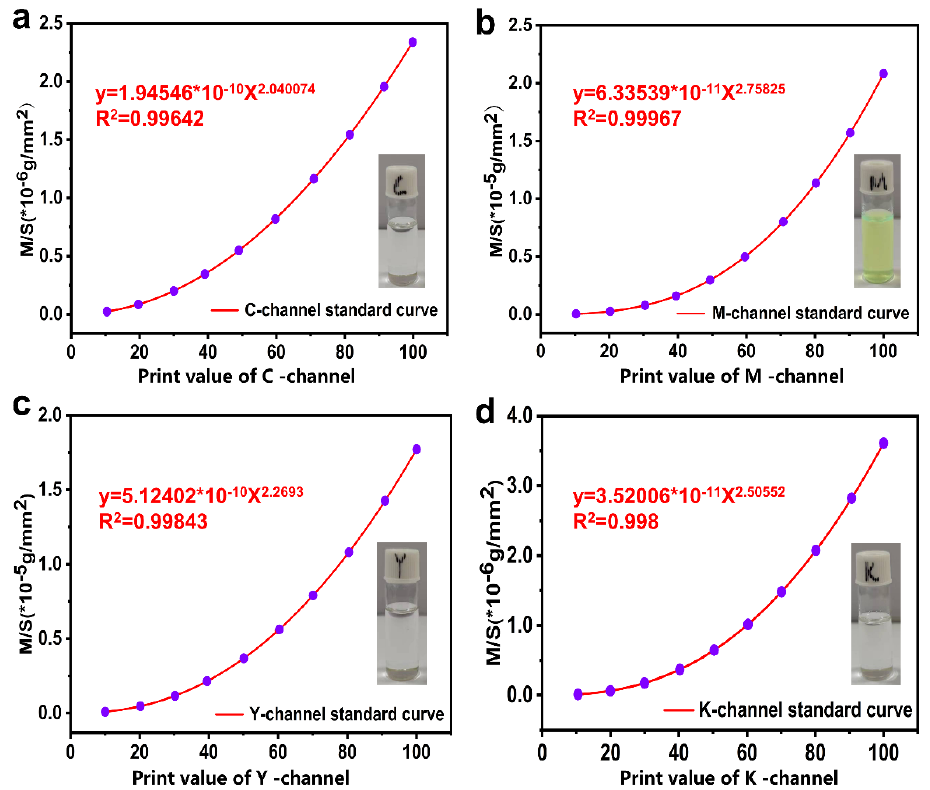
Figure 4. ( a ) C-channel standard curve: y = 1.9456 × 10 −1 0 X 2.040074 , R 2 = 0.99642. The ink used is 5 wt% S811. ( b ) M-channel standard curve: y = 6.33539 × 10 −1 1 X 2.75825 , R 2 = 0.99967. The ink used is 0.25 wt% 5 wt% S811. ( b ) M-channel standard curve: y = 6.33539 × 10 − 11 X 2.75825 , R 2 = 0.99967. The ink used is DC8. ( c ) Y-channel standard curve: y = 5.12402 × 10 −1 0 X 2.2693 , R 2 = 0.99642. The ink used is 40 wt% 0.25 wt% DC8. ( c ) Y-channel standard curve: y = 5.12402 × 10 − 10 X 2.2693 , R 2 = 0.99642. The ink used SLC-1717. ( d ) K-channel standard curve: y = 3.52006 × 10 −1 1 X 2.50552 , R 2 = 0.99642. The ink used is 5 is 40 wt% SLC-1717. ( d ) K-channel standard curve: y = 3.52006 × 10 − 11 X 2.50552 , R 2 = 0.99642. The wt% M.